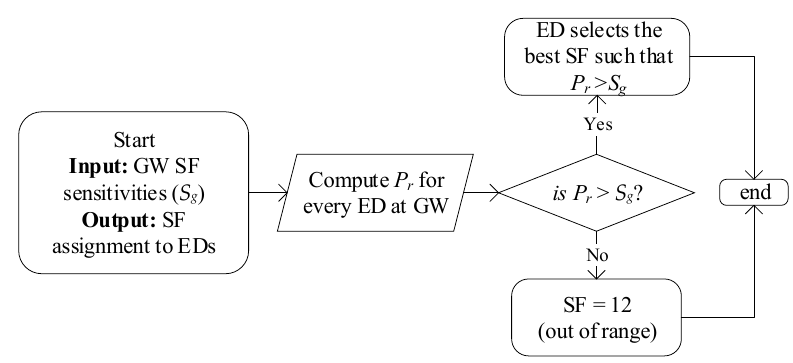
Figure 3. Working procedure of I-SFA scheme [24].